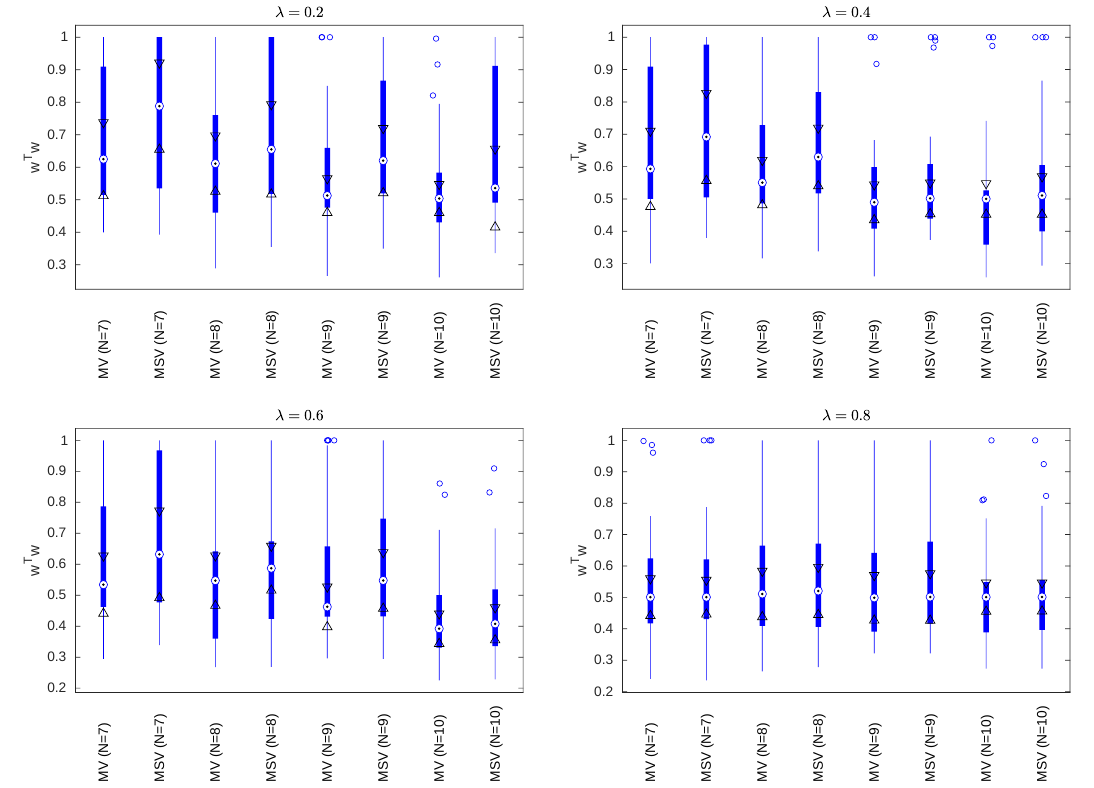
Figure 2. The boxplots of diversification for the MV and MSV strategies for N ∈ { 7,8,9,10 } and λ ∈ { 0.2,0.4,0.6,0.8 } . The MSV tends to produce more concentrated portfolios than its MV counterpart when the expected return of the portfolio is within the range [ 0.5, 1.0 ] , as can be seen in Figure 2. In cases where the randomly generated expected returns are within the range [ 0.0, 0.5 ] , the results (with respect to the diversification level) are just the opposite. As expected, the difference in concentrations is reduced when λ is close to one, since both of the portfolios converge to the GMV portfolio when λ =